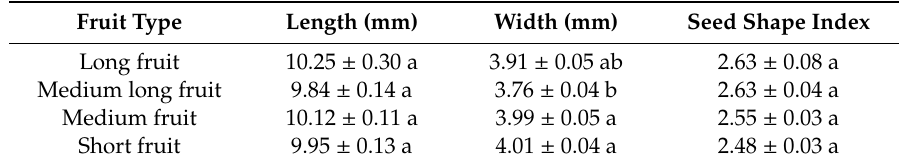
Table 2. Seed shape traits of four types of bar fruits.